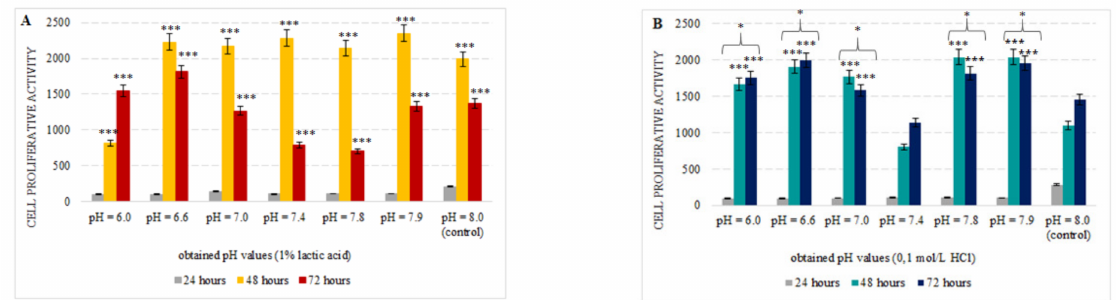
Figure 1. Cancer cell proliferation activity (Colon 26) after correction of pH values of the culture medium by 1% lactic acid ( A ) and by 0.1 mol/L hydrochloric acid ( B ) after 24, 48, and 72 h of cultivation. The levels of statistical significance (*** p < 0.001) in the individual group experimental series (n = 3) with lactic acid (group 1) or HCl (group 2) for 48 and for 72 h were determined. The level of statistical significance (* p < 0.05) between two periods of incubation (48 h and 72 h) with HCl was also